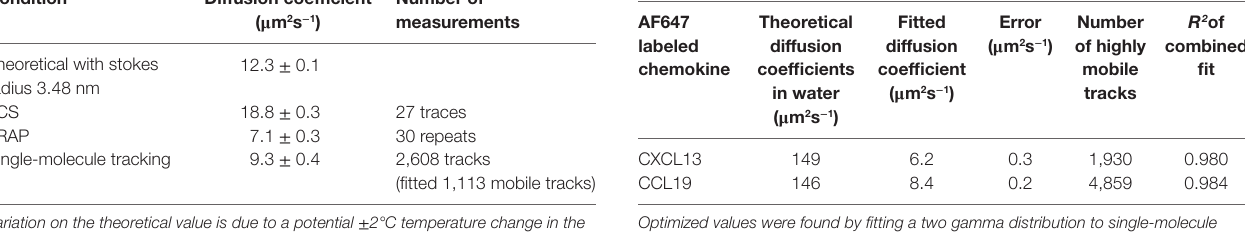
TaBle 3 | Diffusion coefficients of CXCL13 and CCL19 in